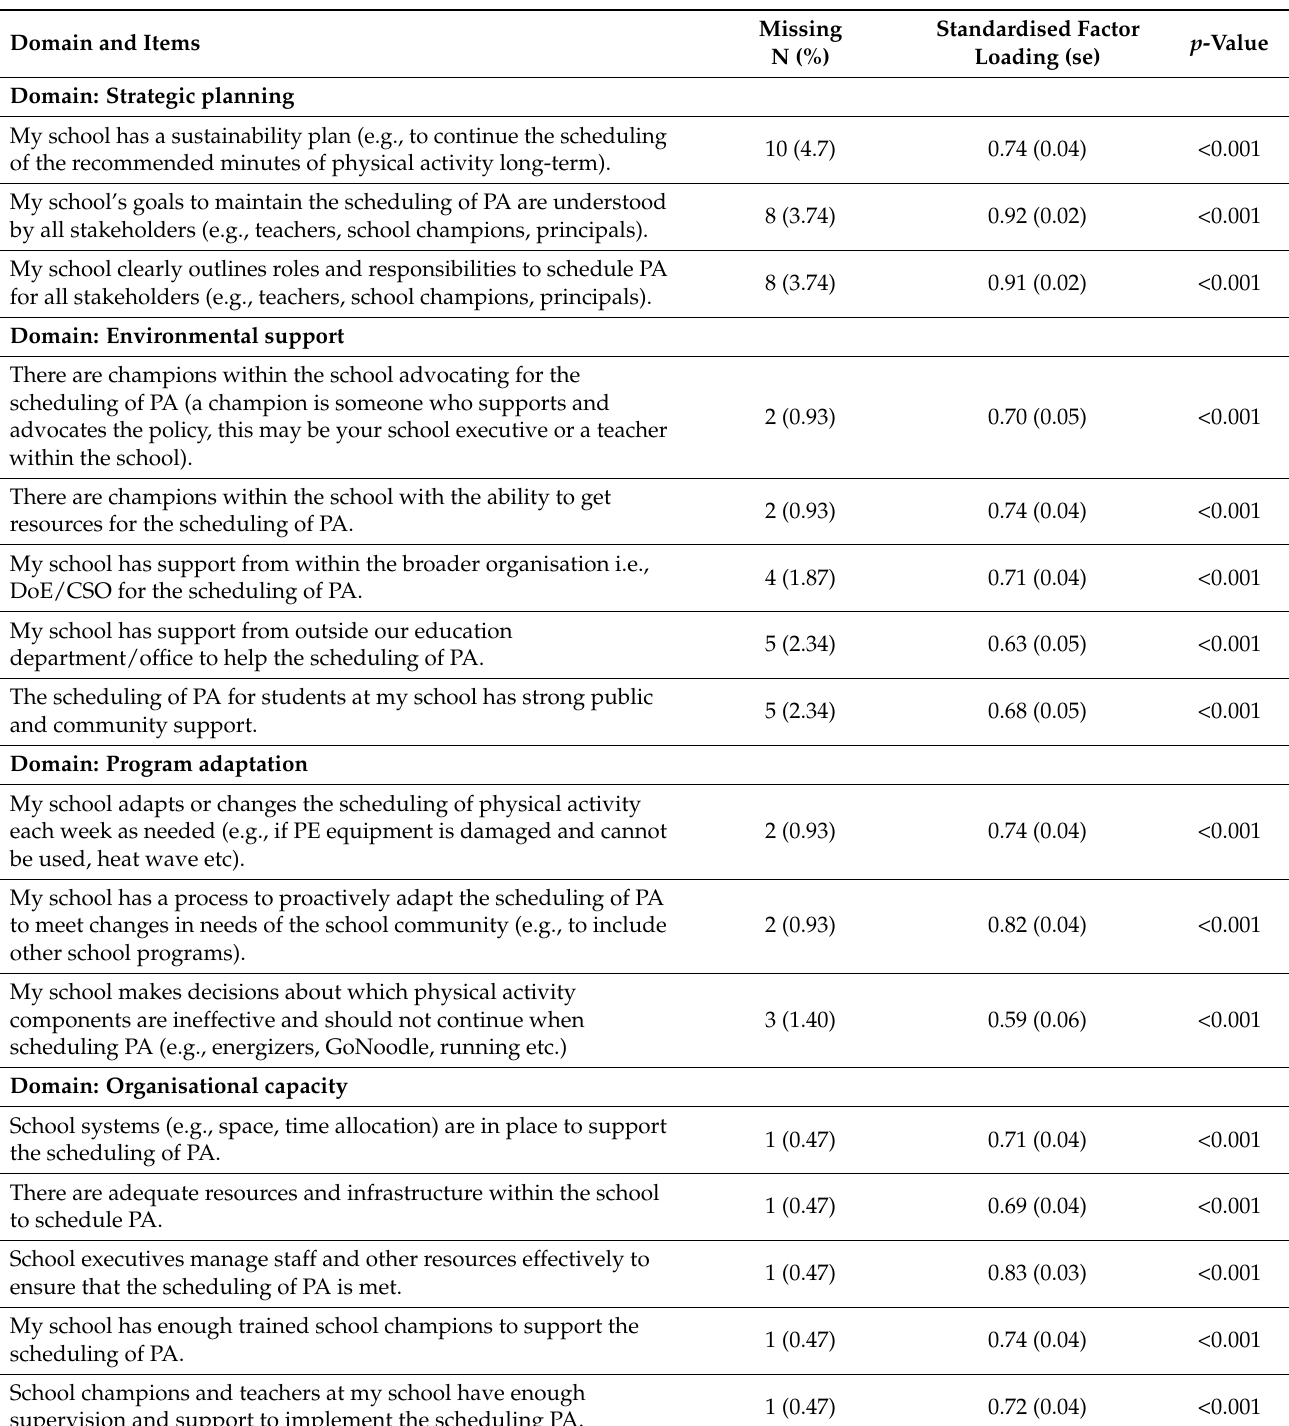
Table 2. Item-level information for the final adapted